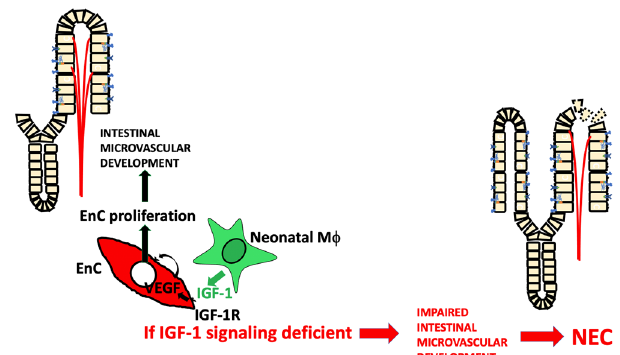
Fig. 9 IGF-1 released from embryonically derived macrophages binds to IGF-1R on endothelial cells to activate VEGF expression, leading